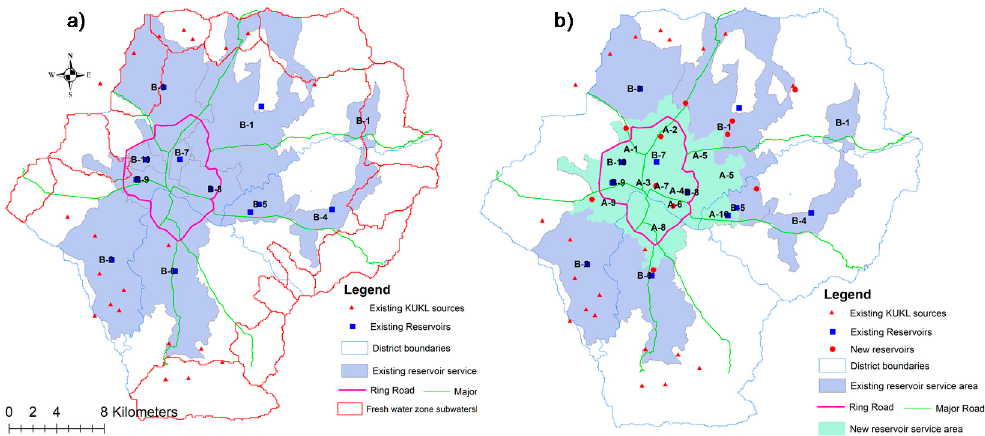
Figure 1. Study area showing ( a ) conservation zone for freshwater, KUKL’s existing sources and service areas, and hydro meteorological stations, ( b ) planned water supply service areas after Melamchi Water Supply Project (MWSP). New reservoir service areas will get water from MWSP and existing reservoirs will get water from the existing network.